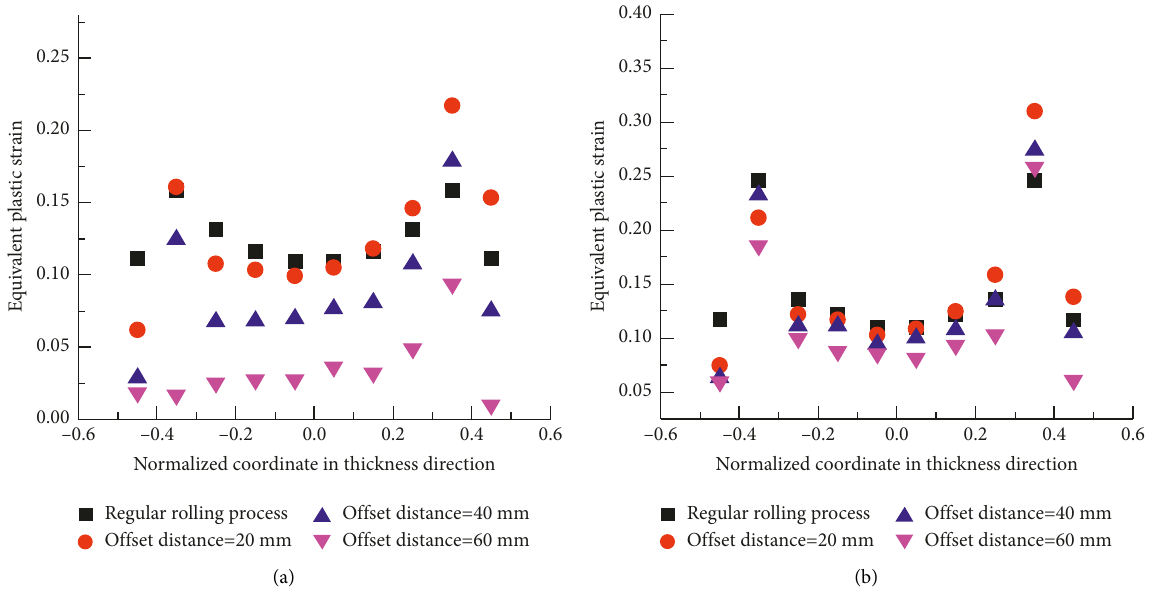
Figure 8: Distribution in thickness direction of equivalent plastic strain inside the plate with speed ratio being 1.05: (a) initial thickness is 50mm; (b) initial thickness is 100mm.